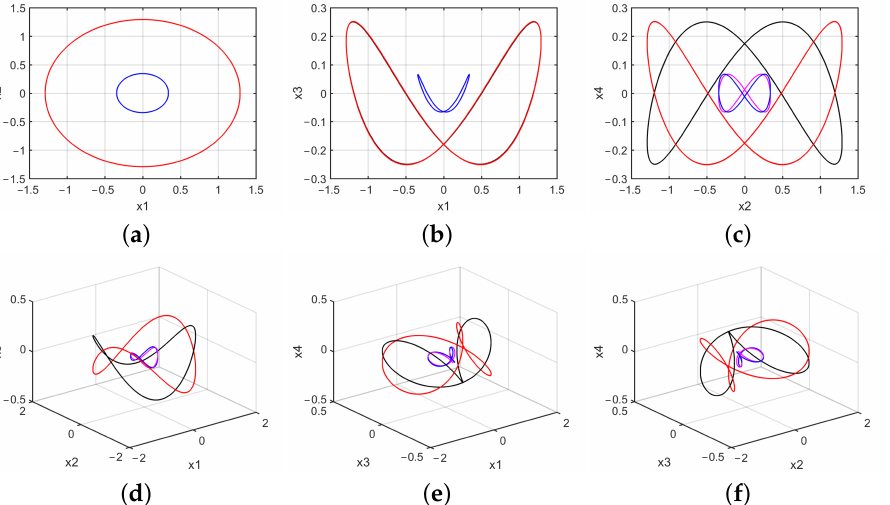
Figure 6. Morphology and relative positions of four periodic solutions when f 1 = 15 > f 12 : ( a ) ( x ) plane; ( b ) ( x ) plane; ( c ) ( x 1 , x 2 1 , x 3 ( x ) 2 , x 3 , x 4